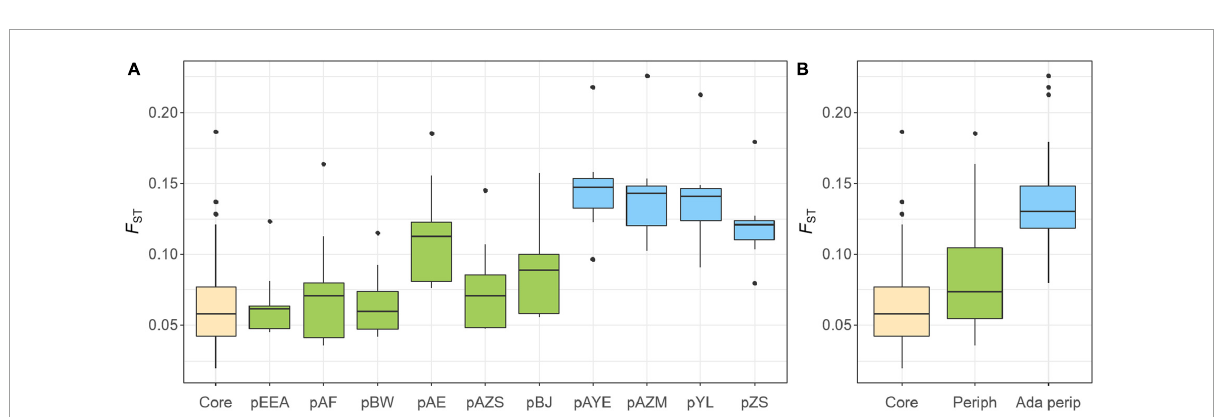
FIGURE5 Population genetic differentiation ( F ST ) within the core populations (yellow), between the core and non-adaptive peripheral populations (green), and between the core and adaptive peripheral populations (blue). F ST is displayed at (A) the population level and (B) the group level of core, non-adaptive peripheral, and adaptive peripheral